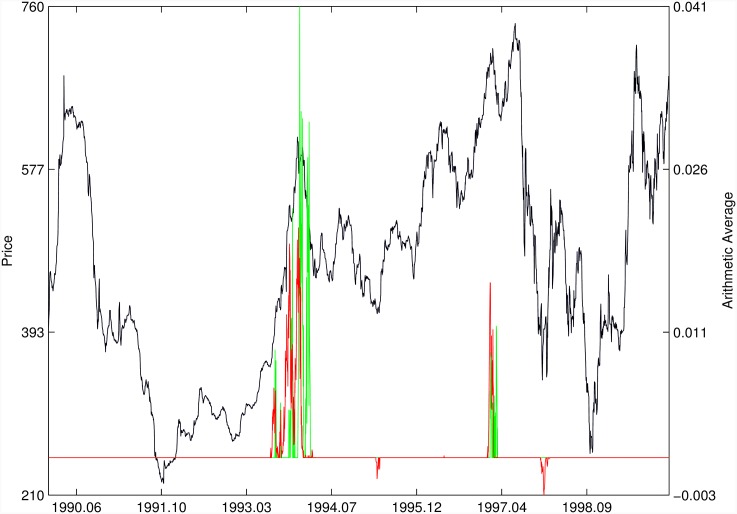
Indonesia 1994/1997.Same as Fig 10.